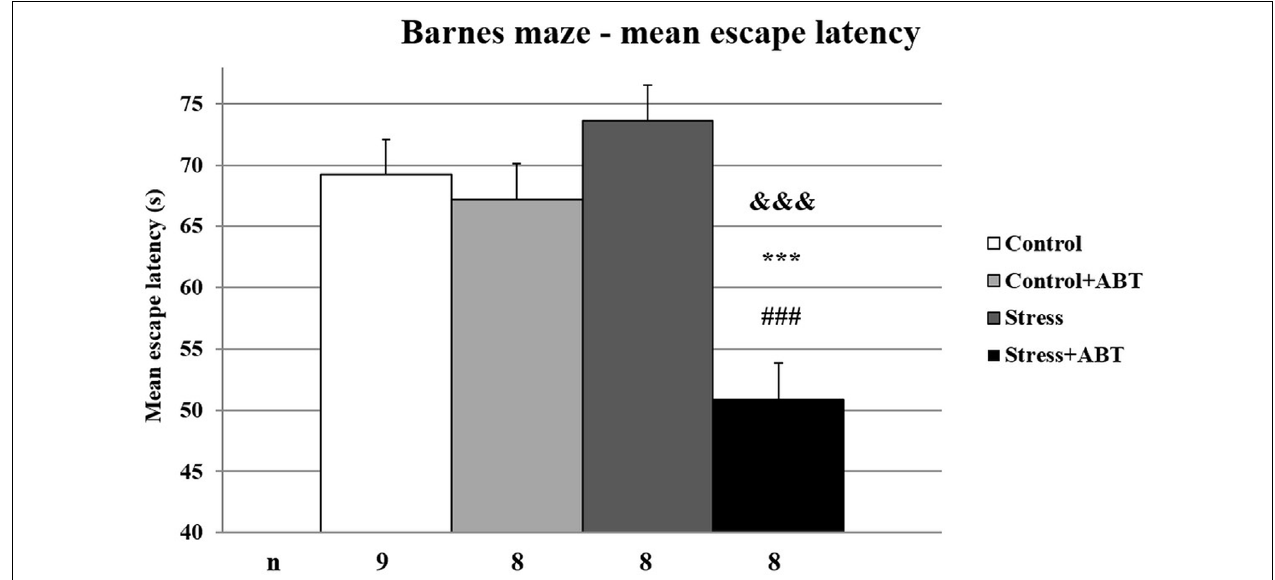
FIGURE 4 | Effects of chronic stress, long-term ABT-239 treatment on mean escape latency in the spatial memory test of the Barnes maze (BM) task. Each column represents the mean ± SEM of six trials (two trials per day for 3 days) obtained from n rats indicated at the bottom of the figure. The three groups demonstrated significantly different results in mean latencies of reaching escape hole in the BM in comparison with Stress + ABT: *** p < 0.001 vs. Control, ### p < 0.001 vs. Stress, &&& p < 0.001 vs. Control +